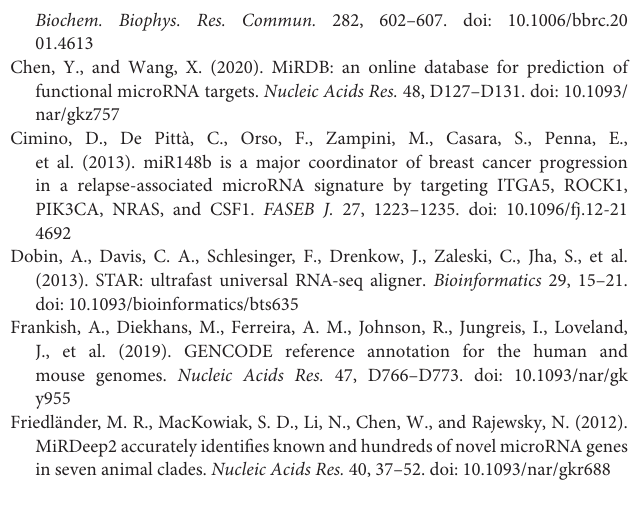
Supplementary Table 1 | The results of differential gene expression analysis. Supplementary Table 2 | The results of differential miRNA expression